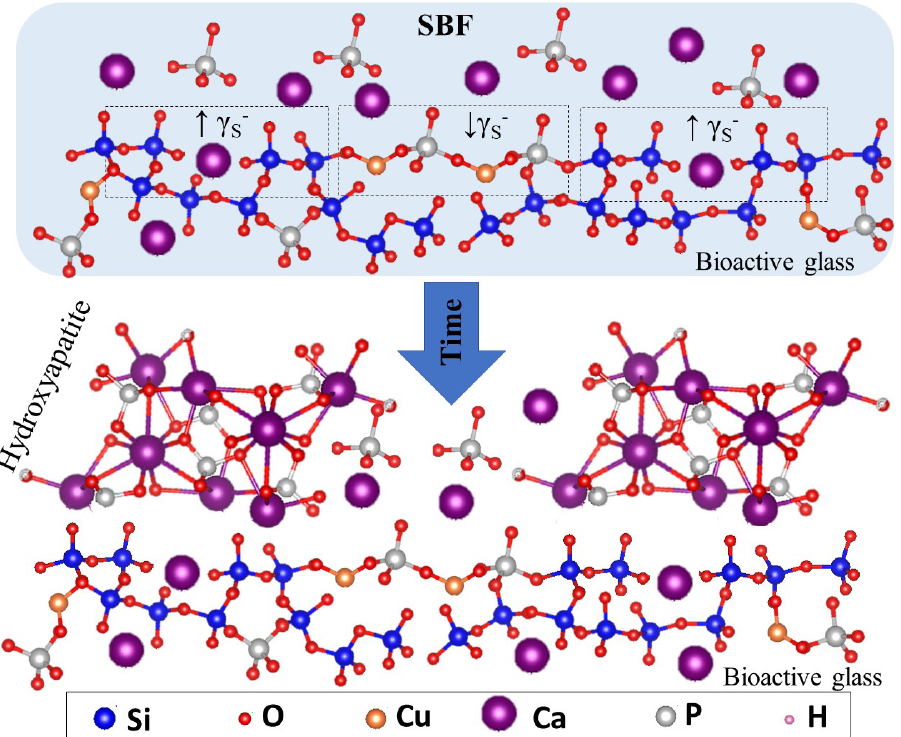
Figure 5. Schematic illustration of hydroxyapatite precipitation on CuO-containing bioactive glasses. The Cu-O-P bonds are more covalent than the Ca-O-P bonds, which yield regions with lower electron donor parameter values. These regions weakly attract Ca 2+ ions and, consequently, are less susceptible to hydroxyapatite